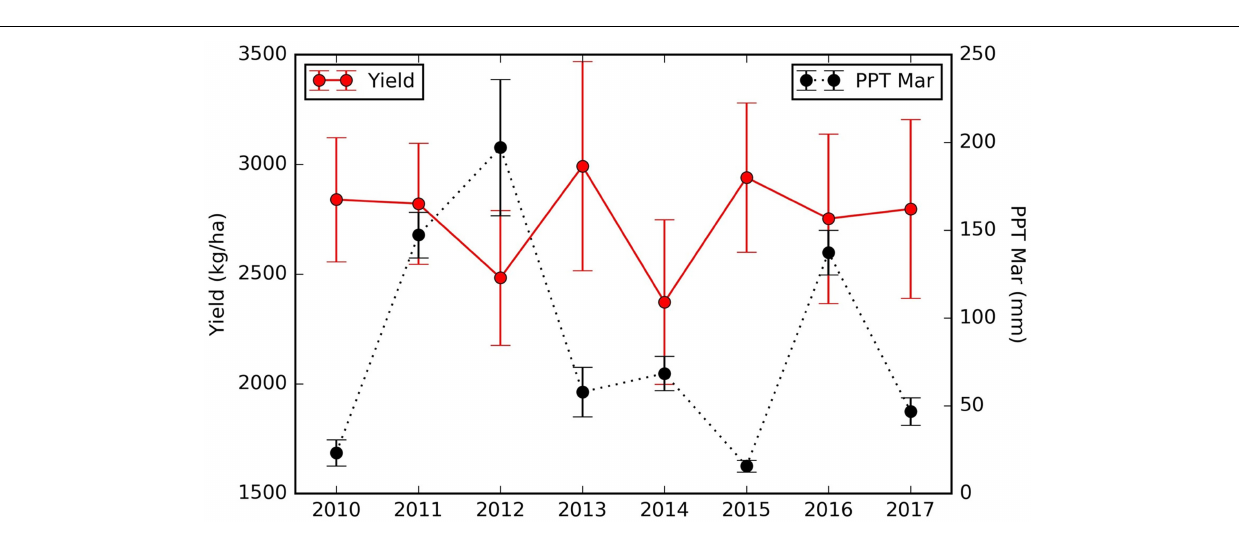
FIGURE 12 | Time series of almond yield and March precipitation for the orchards in node #5 ( Figure 10